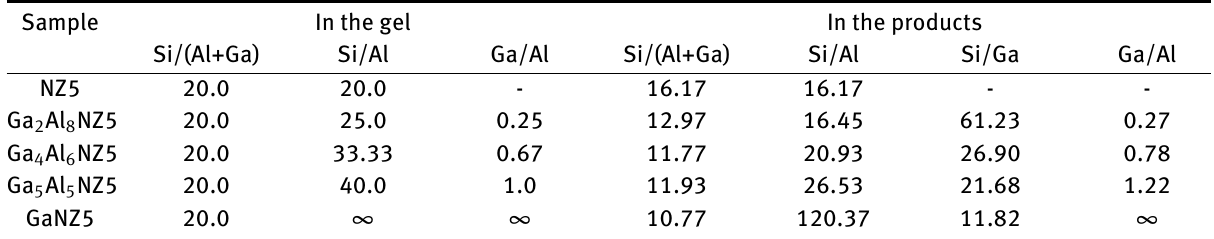
Table 3: Chemical composition of nanosized ZSM-5 zeolite and samples isomorphously substituted by Ga [8] Sample